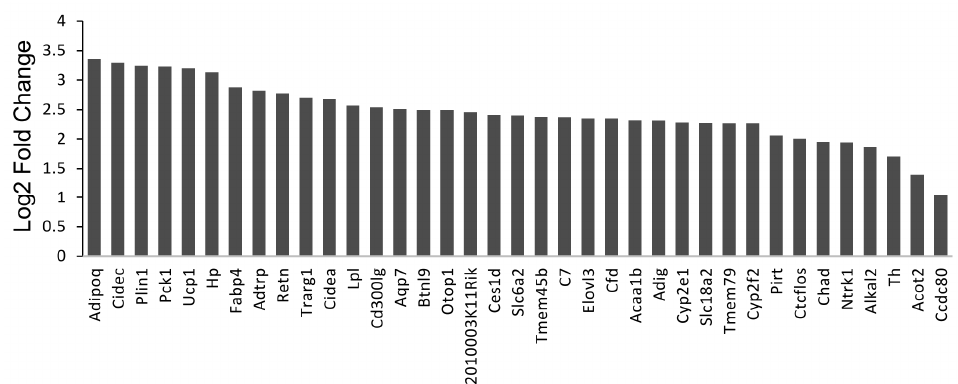
Figure 6. Deletion of TG2 from astrocytes results in an upregulation of genes involved in lipid uptake and metabolism following SCI. Five mm of spinal cord surrounding the lesions were collected from TG2-A-cKO and TG2fl/fl mice at 12–16 weeks of age (4 mice in each group) 3 days post-injury, RNA isolated and used for RNA-seq. Thirty-seven genes were increased in injured spinal cord from TG2-A-cKO compared to TG2fl/fl mice. Graphic representation of log fold changes in gene expression in spinal cords from TG2-A-cKO is shown.